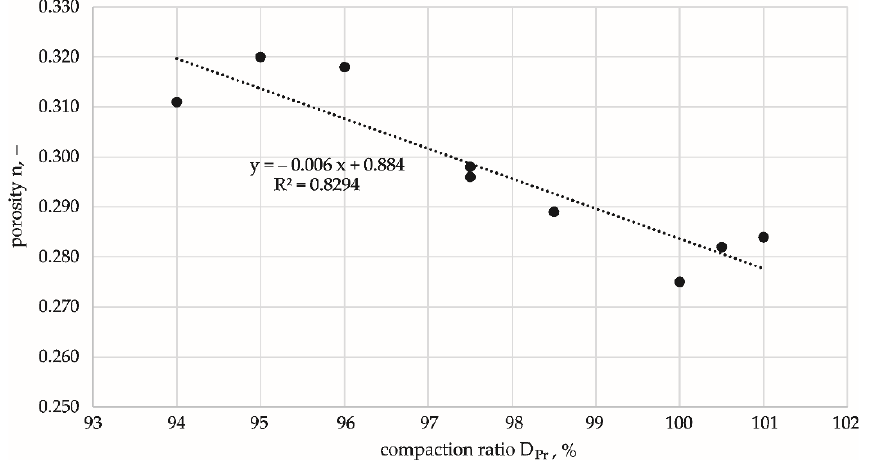
Figure 3. Actual compaction of test specimens vs. porosity.